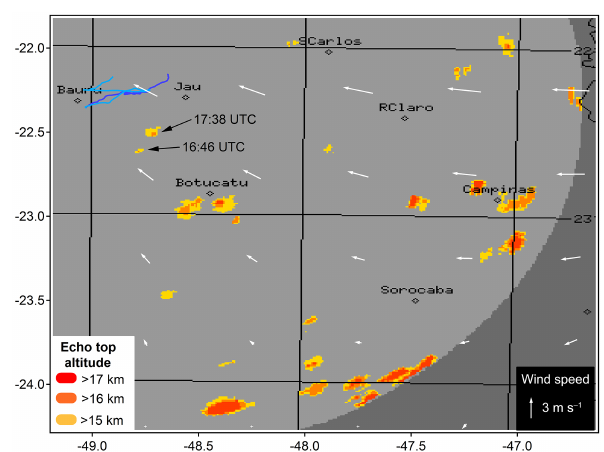
Figure 5. Composite radar image of all convective cells reaching above 15km detected on 13 March by IPMet radar in the upwind quadrant of Bauru. Black arrows tag the overshooting cells poten- tially responsible for the hydrated layers shown in Fig. 4 with indi- cation of the UTC of their detection by radar. White arrows repre- sent the mean wind field between 100 and 70hPa from ERA-Interim reanalysis (18:00UTC). Blue lines indicate the balloon trajectories (FLASH-B dark blue, Pico-SDLA light